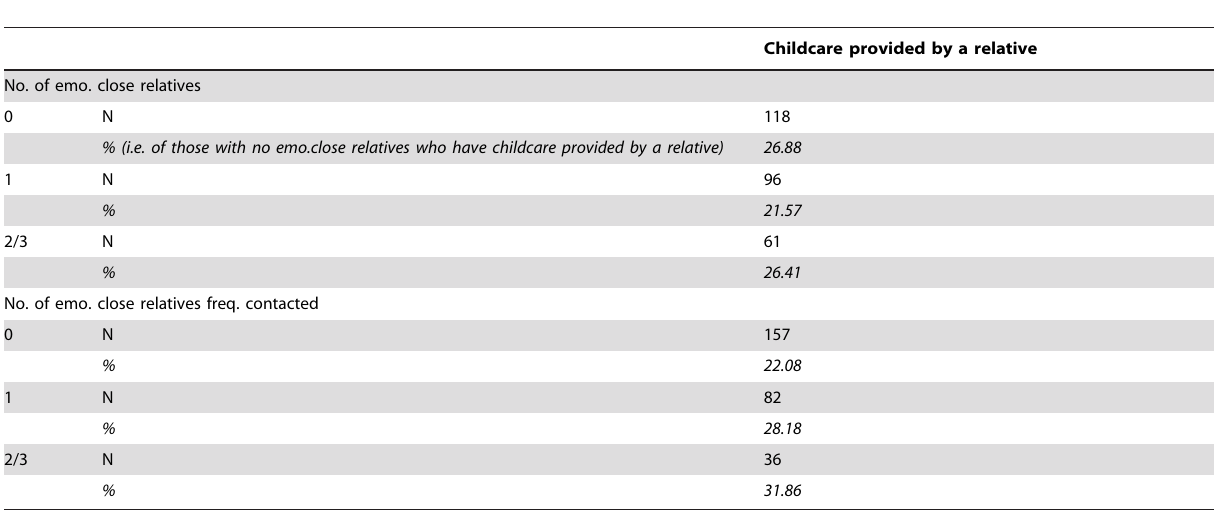
Table 6. Bivariate relationship between number of family in the friendship group and childcare provision by relatives.